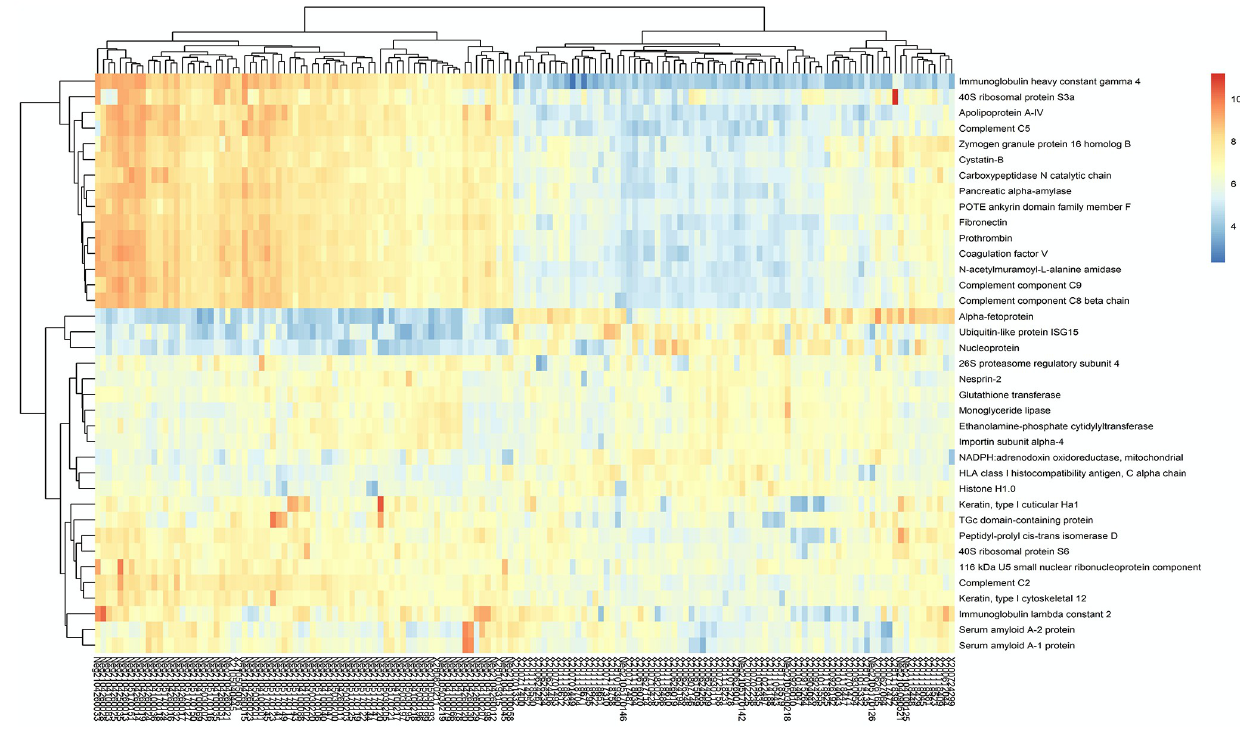
Fig 2. Heat map of the significantly up- and down- regulated proteins in SARS-CoV-2 positive patient samples. Different colors indicated the KNN imputed and VSN normalized abundance of proteins in different patient samples.